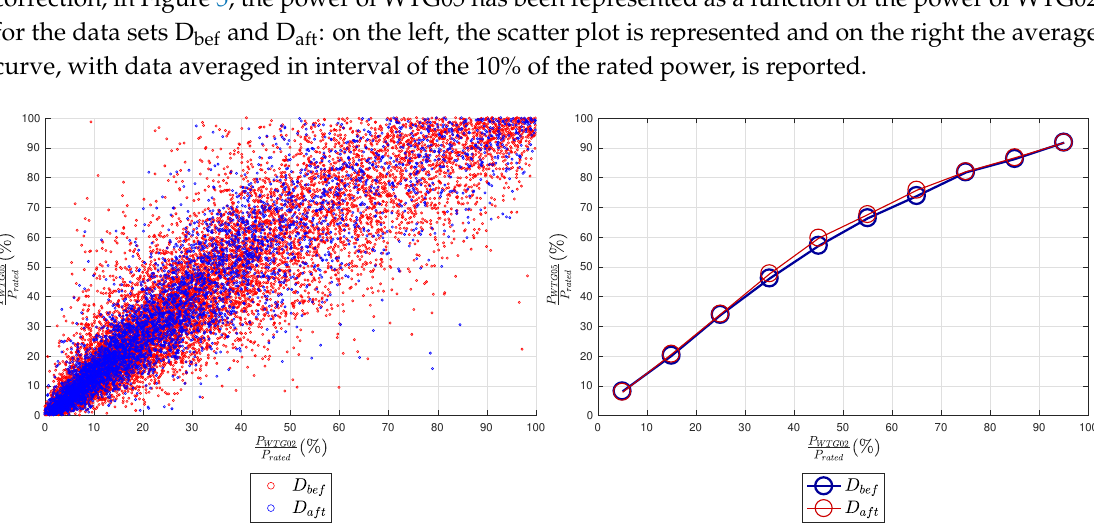
Figure 5. Representation of the P WTG 06 as a function of P WTG 02 for data sets D bef and D aft : scatter plot ( left ) and average curve ( right